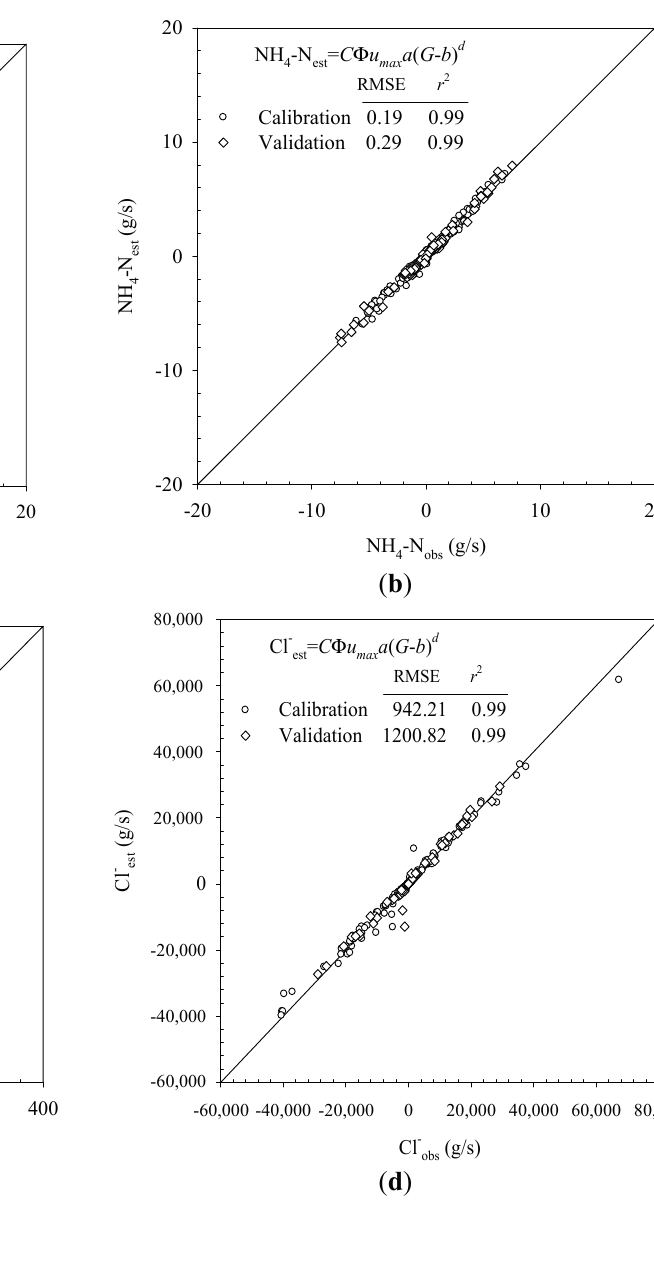
Figure 6. Accuracy and reliability of the pollutant flux estimation by using the